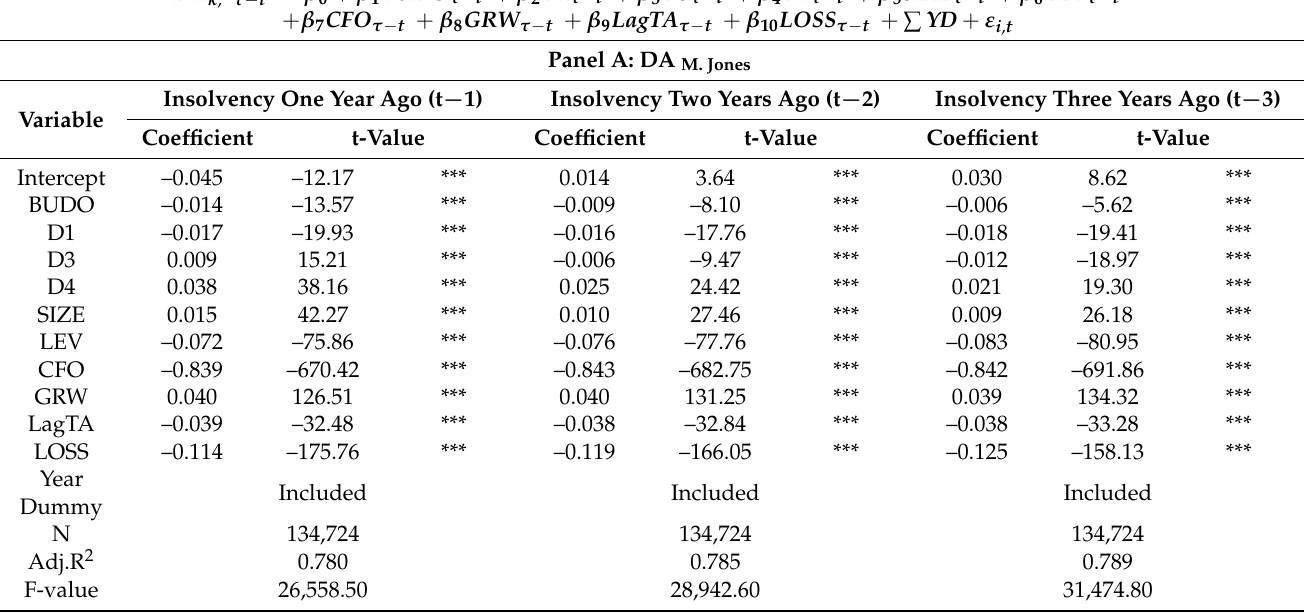
Table 8. Differences in discretionary accruals between insolvent and non-insolvent